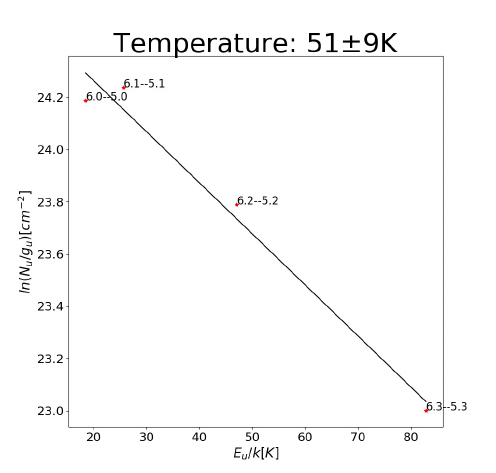
Figure 5. The rotation diagram of CH 3 CN. Each point represents an energy transition. The derived temperature is 51 ± 9K.